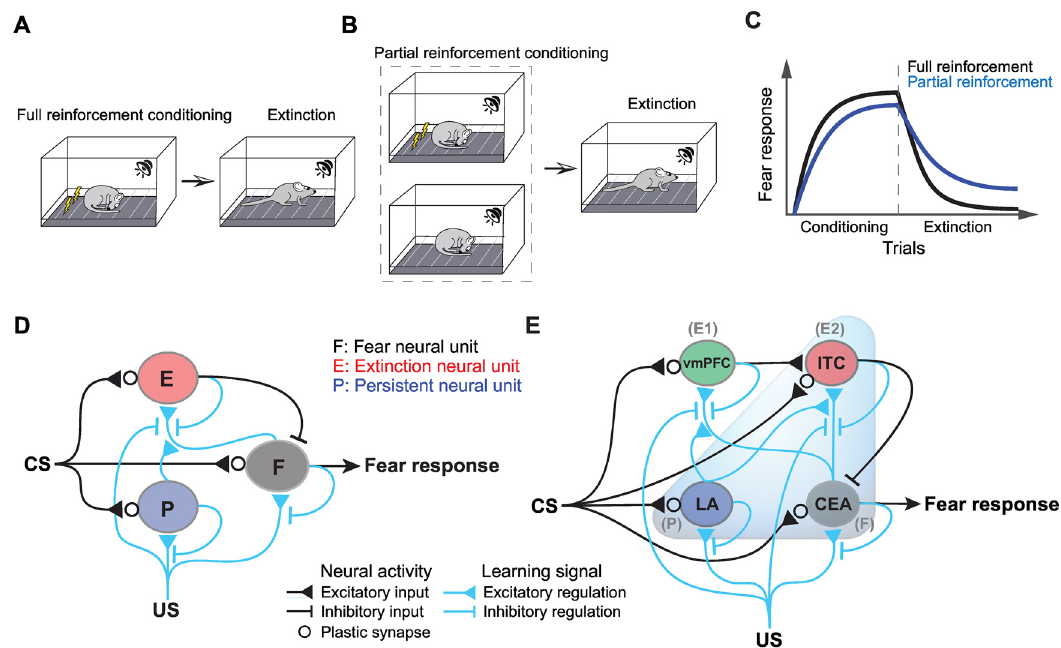
Fig 1. Partial reinforcement effect and the neural circuit models. (A, B) During fear conditioning, a CS, e . g ., a tone, was fully (in the full reinforcement schedule (A) ) or partially (in the partial reinforcement schedule (B) ) paired several times with a US, e . g ., electric foot shock ( left panels ). The fear memory formed during fear conditioning can be diminished by extinction training, during which the CS is repeatedly presented alone, without the US ( right panels ). (C) Conditioned responses to the CS, which are usually measured as the degree of behavioral freezing responses, are depicted during fear conditioning and extinction. The fear memory (measured as the degree of behavioral freezing responses) that was acquired through the partial reinforcement schedule with P(US|CS) < 1 exhibits a PREE ( blue line ), which is evident as increased resistance to extinction compared to that of the fear memory acquired through the full reinforcement schedule with P(US|CS) = 1 ( black line ). (D, E) The two neural circuit models are shown as schematics. Black and blue lines describe synaptic connections and the learning signals that regulate plasticity at synapses indicated by black open circles, respectively. (D) The basic model based on fear, persistent and extinction neural units (F, P and E). CS-related input activates all the units, and the extinction neural unit inhibits the fear neural unit, the activity of which represents the strength of the fear memory (black lines) (eqs (1 – 3)). The efficacy of CS-related input to the fear, persistent and extinction neural units changes based on the learning signals (blue lines) (eqs (4 – 6)). (E) Extended model including subregions of the amygdala (the LA, CEA and ITC) as well as the vmPFC. In this model, the LA and CEA correspond to persistent and fear neural units, respectively, and there are two extinction neural units: the ITC and vmPFC. CS-related input activates all subregions, and the ITC receives excitatory input from the vmPFC and inhibits the CEA (black lines) (eqs (7 – 10)). A behavioral fear response was triggered by the CEA. The efficacy of plastic synapses (black open circles) changed based on learning signals (blue lines) (eqs (11 – 14)). Parameter values are listed in S1